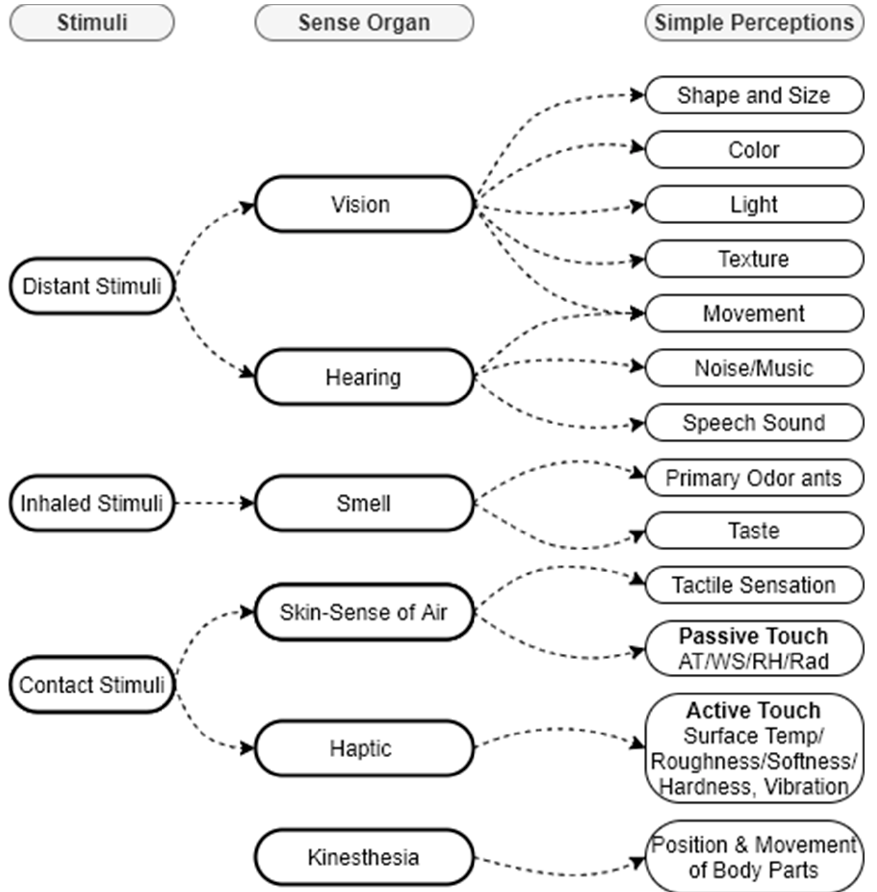
Figure 6. Human sensory perceptions in built environment [15,17,49,54,63].